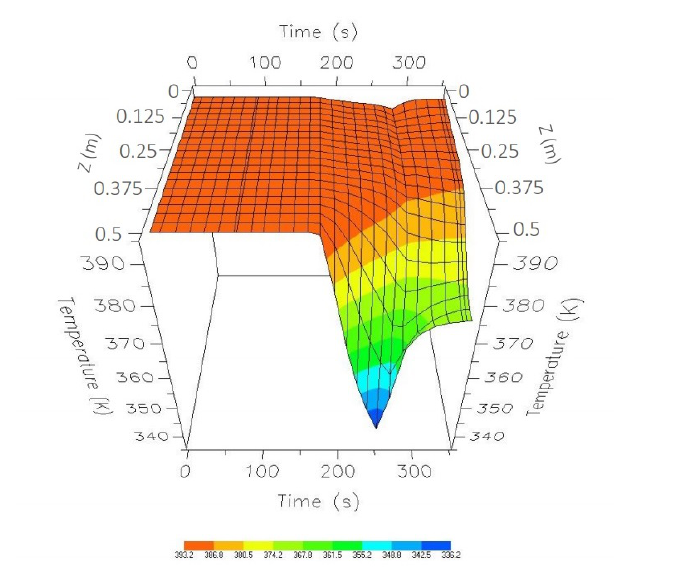
Figure 12. One-cycle temperature profile while in CSS.